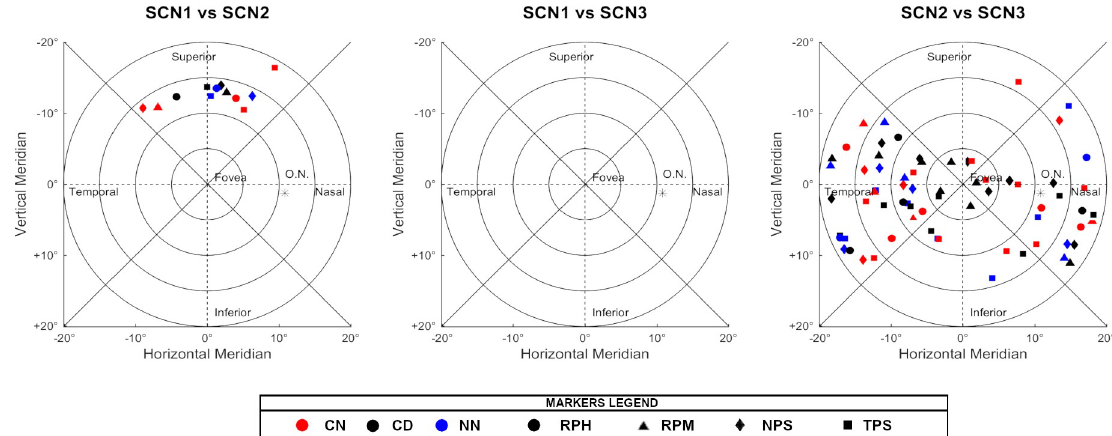
Fig 4. Non-significant differences in the post-hoc analysis when comparing the different scenarios. The absence of markers indicates that those regions were significantly different under all conditions tested.